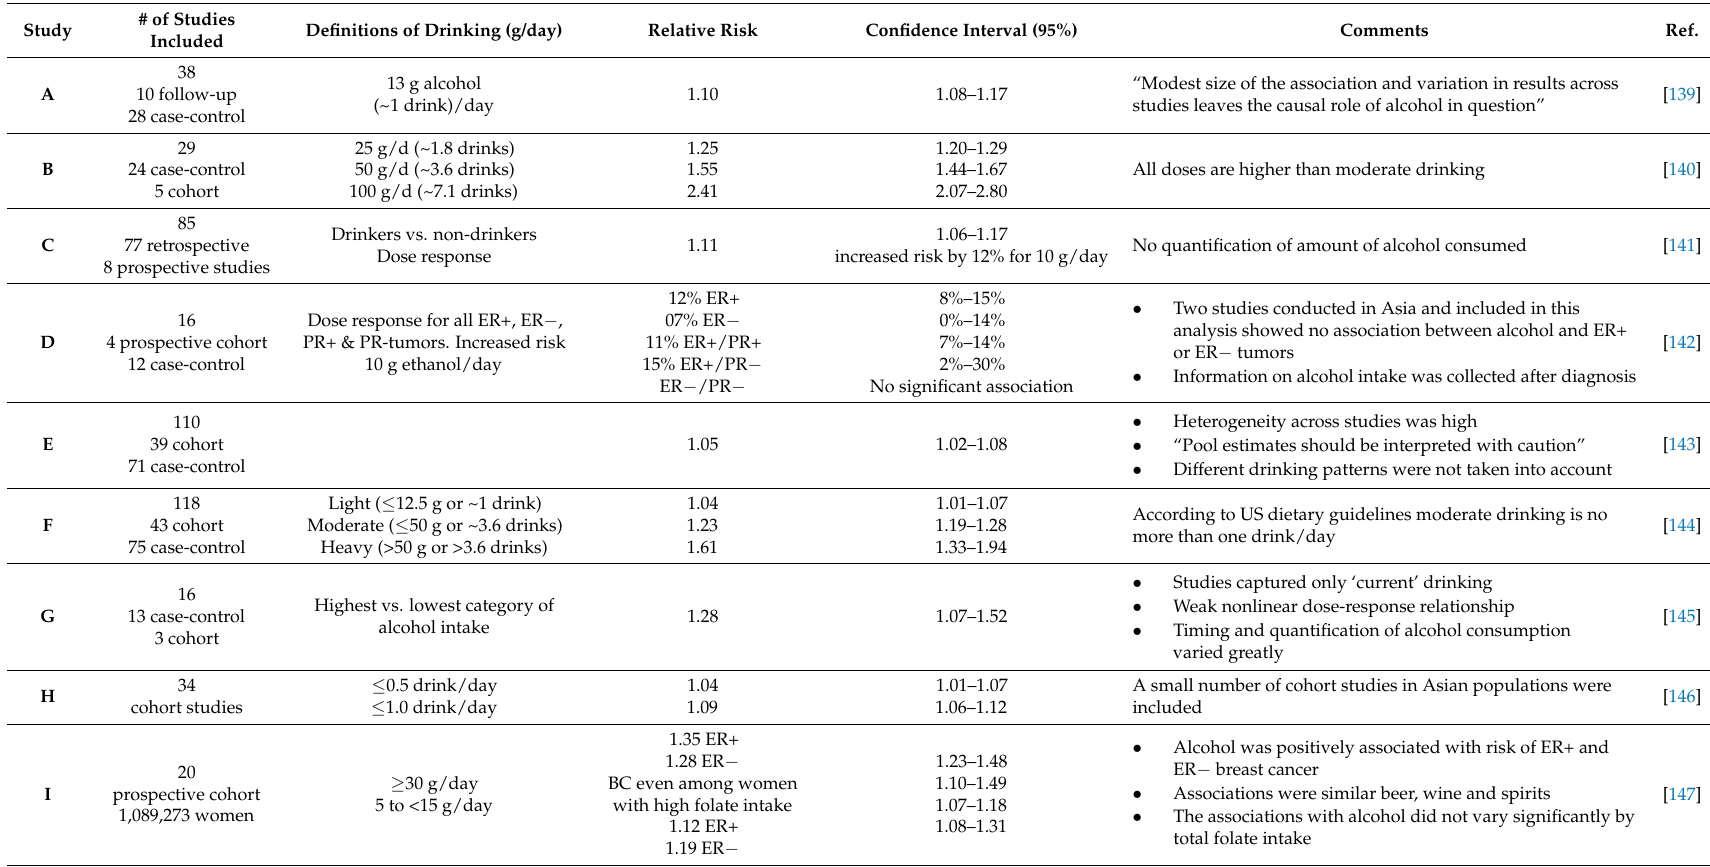
Table 2. Meta-Analysis Studies on Alcohol Consumption and Breast